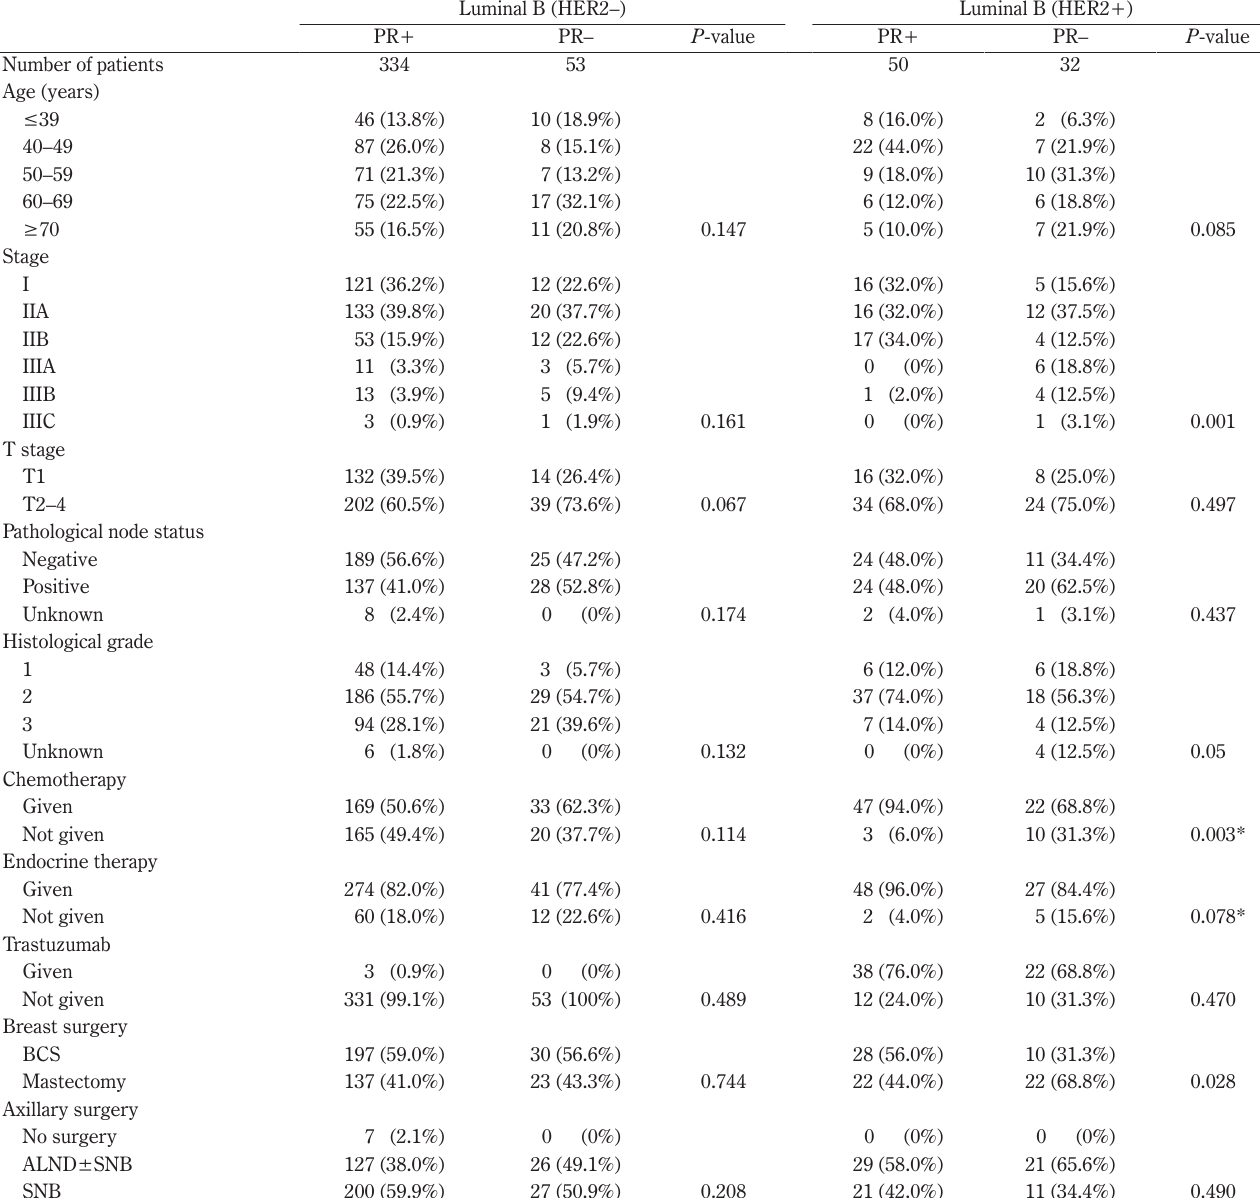
Table 2 Clinical profiles of the 469